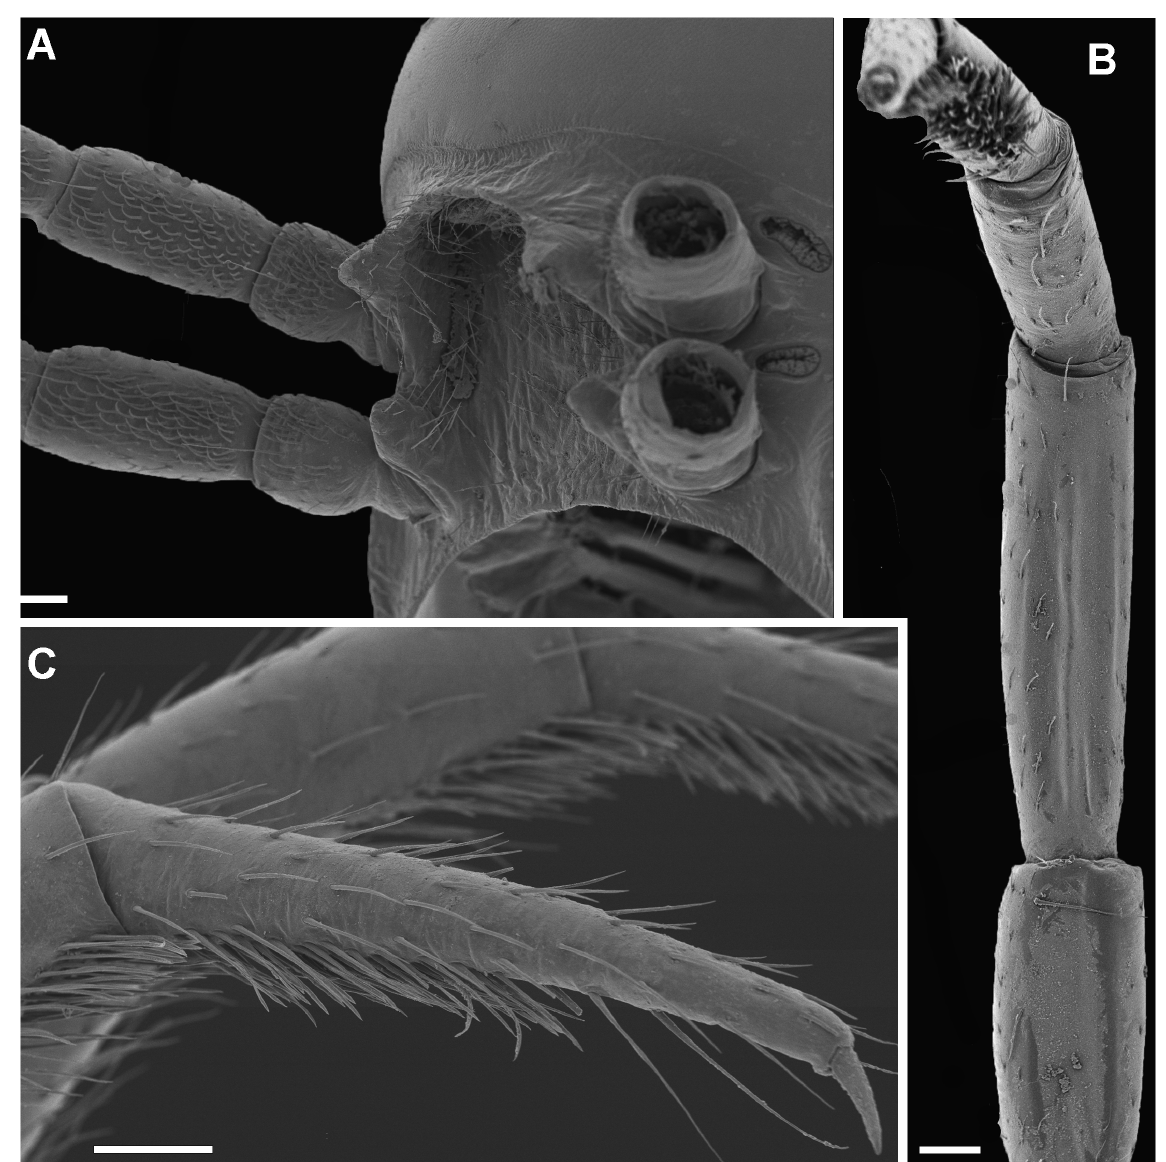
Fig. 26. Eviulisoma sternale sp. nov., holotype. A . Ventral side of 6 th body ring with right side legs, showing lobed rim of excavation. B . Post-gonopodal leg, showing smooth prefemur and femur. C . Pre- gonopodal leg, showing scopula. Scale bars: 0.1